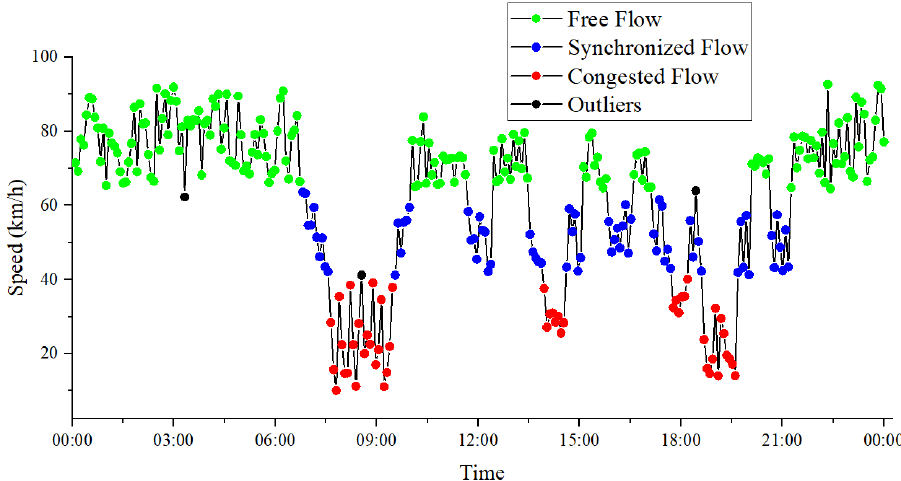
Figure 6. Discrimination results of traffic state in the weaving section of Hang’an Expressway.